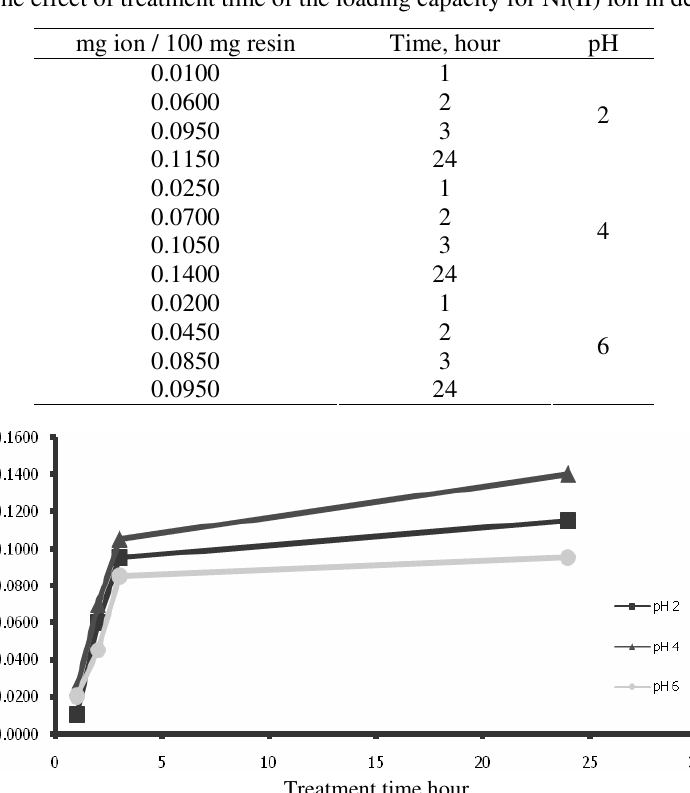
Table 4. The effect of treatment time of the loading capacity for Ni(II) ion in deferent pH.